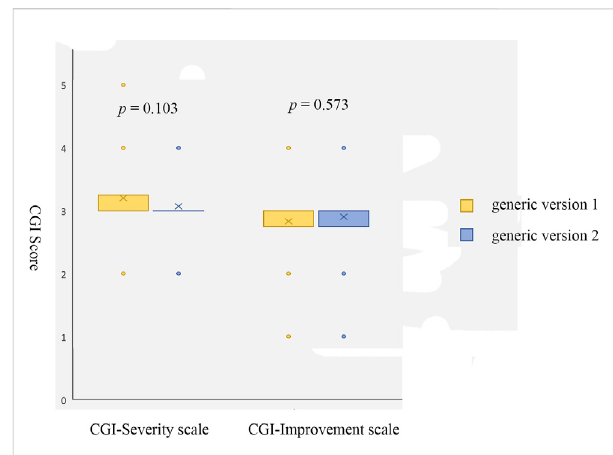
FIGURE 2 Scores of CGI Severity scale and Improvement scale before (generic version 1, the original generic olanzapine) and after (generic version 2, the bid-winning olanzapine) drug